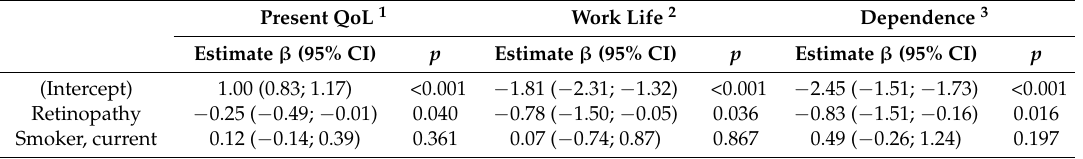
Table 3. Multivariable linear regression models for present quality of life, work life and dependence as reported on the Audit of Diabetes Dependent Quality of Life (ADDQoL-19) questionnaire.